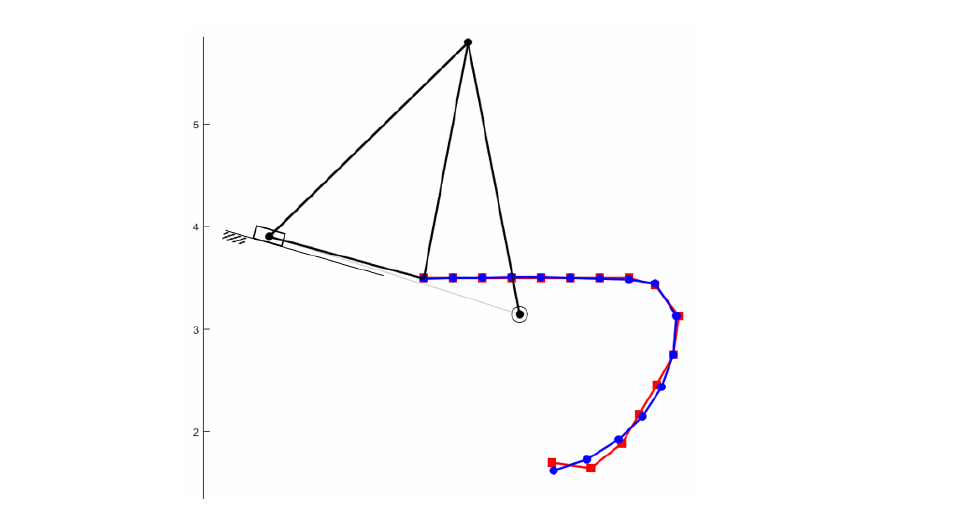
Figure 9. Example 1: comparison to other multi-start solution (multi-start no. 10), E = 0.0227.